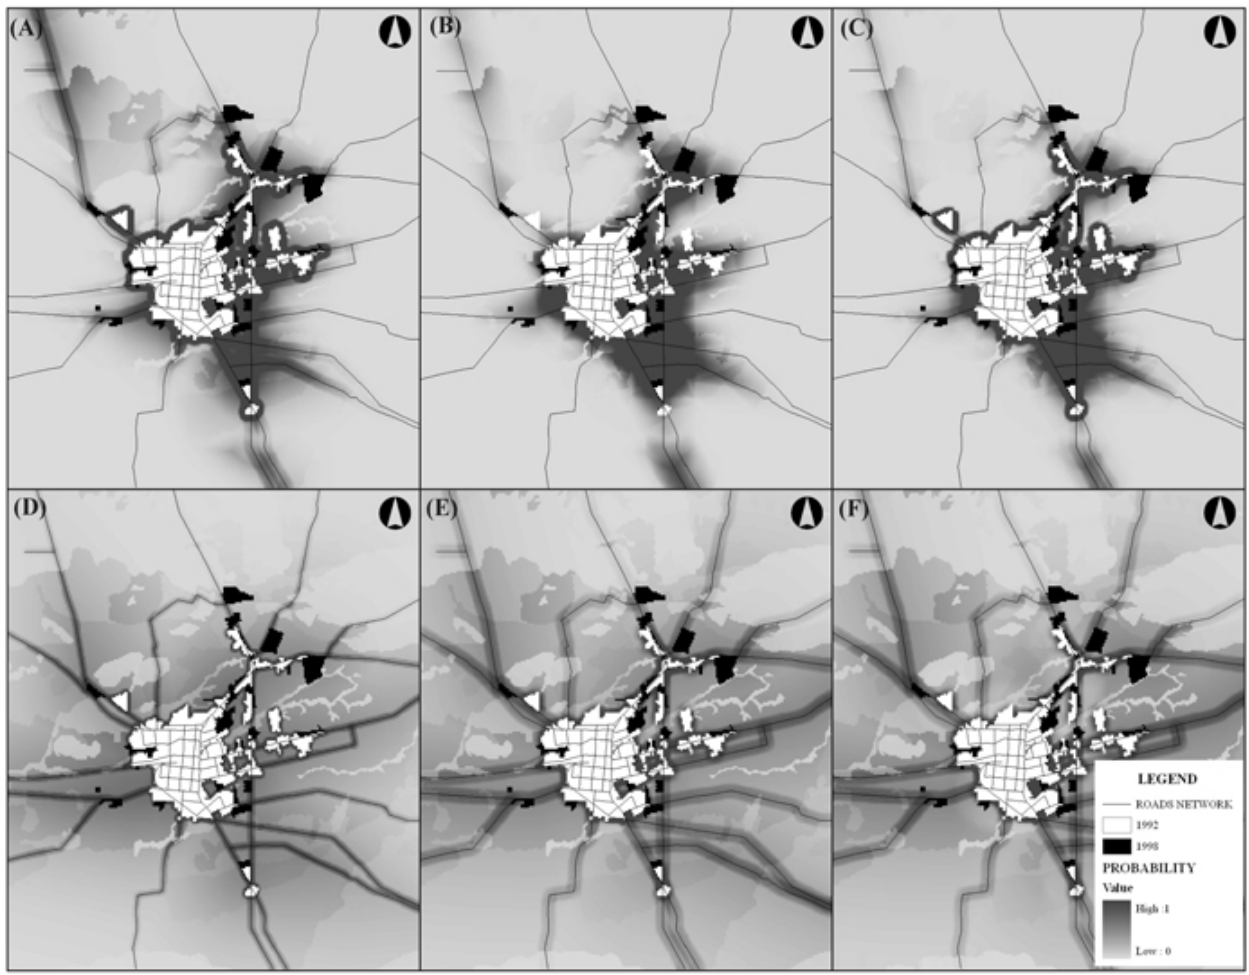
Fig. 4. Model predictions for urban growth in 1998 giving the probability of growth for each cell. (A) Model m8 , (B) model m11 , and (C) model m12 , based on the 3000-m growth surface. de10 de40 de10/40